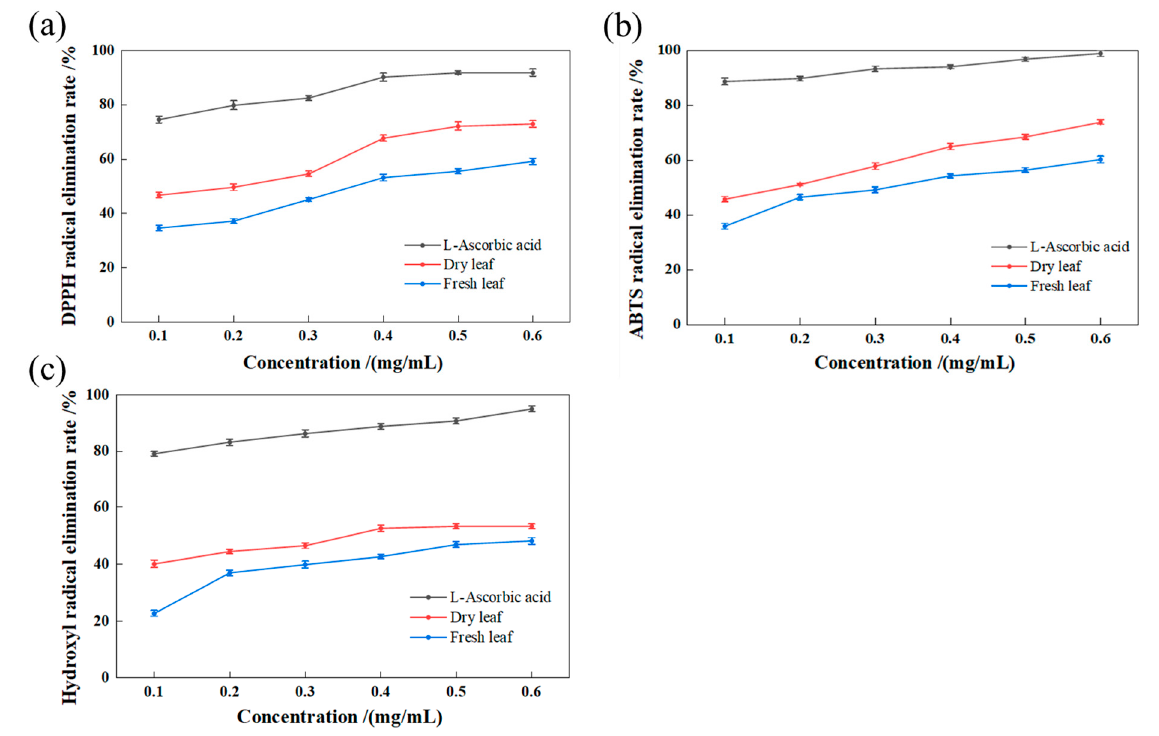
Figure 5. Antioxidant activities ( a )—DPPH radical elimination ability; ( b )—ABTS radical elimination ability; ( c )—hydroxyl radical elimination ability) of total triterpenoids in fresh and dried leaves of LIM.